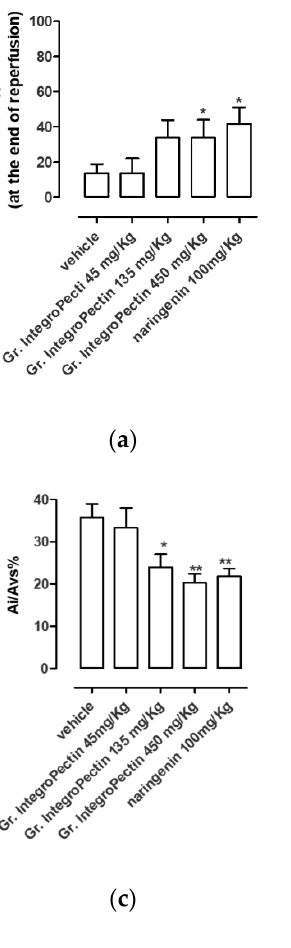
Figure 2. The histograms represent the functional and morphological changes induced by treatment of the animals with grapefruit IntegroPectin, naringenin or with the vehicle before the ischemia/reperfusion episode: ( a ) changes in RPP% at the end of reperfusion; ( b ) changes in dP/dt% at the end of reperfusion; ( c ) changes in the percentage of ischemic area vs. left ventricle area (AI/ALV%). The vertical bars symbolize the standard errors ( n = 6). Asterisks show a statistically significant difference from the value observed in the hearts of vehicle-treated animals (* p < 0.05; ** p < 0.01).